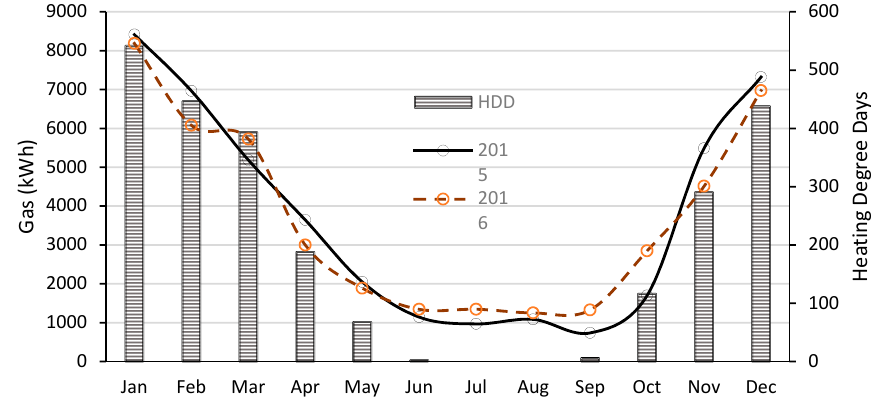
Figure 3. Gas consumption based on heating degree days (HDD).